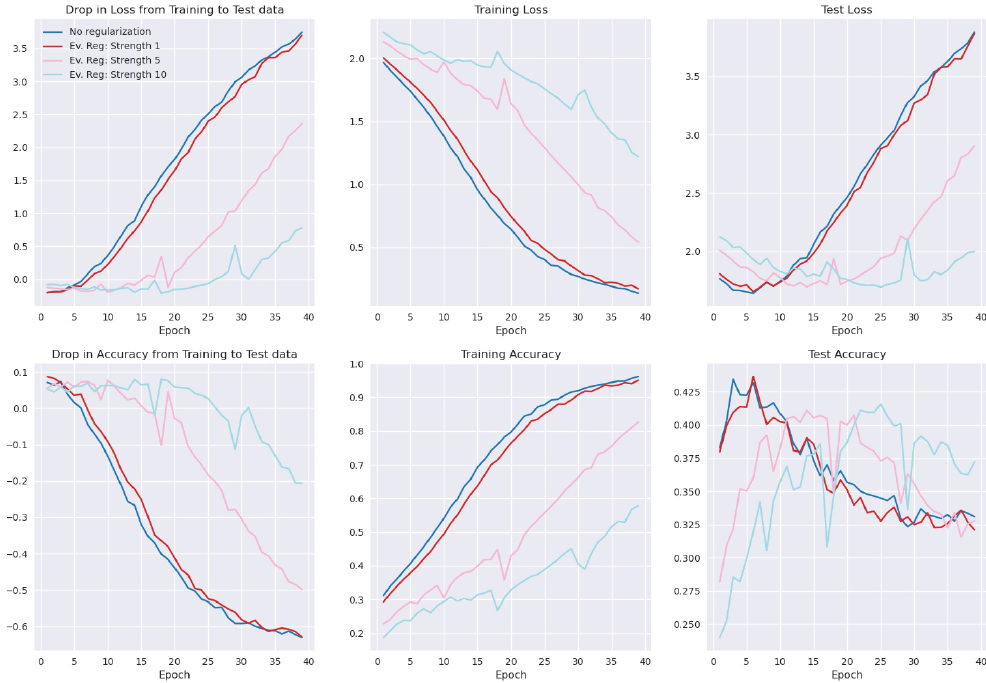
Figure 9. Loss and accuracy for CIFAR-10 with noisy labels for training and test data. As would be expected, overfitting is stronger for noisy labels with the unregularized network or the weakly-regularized network (EBR with strength 1.0): After 40 epochs, the drop in accuracy between training and test data is more than 60 percentage points. With stronger regularization, the accuracy of the test data remains elevated throughout training and there is a much smaller difference between training and test data